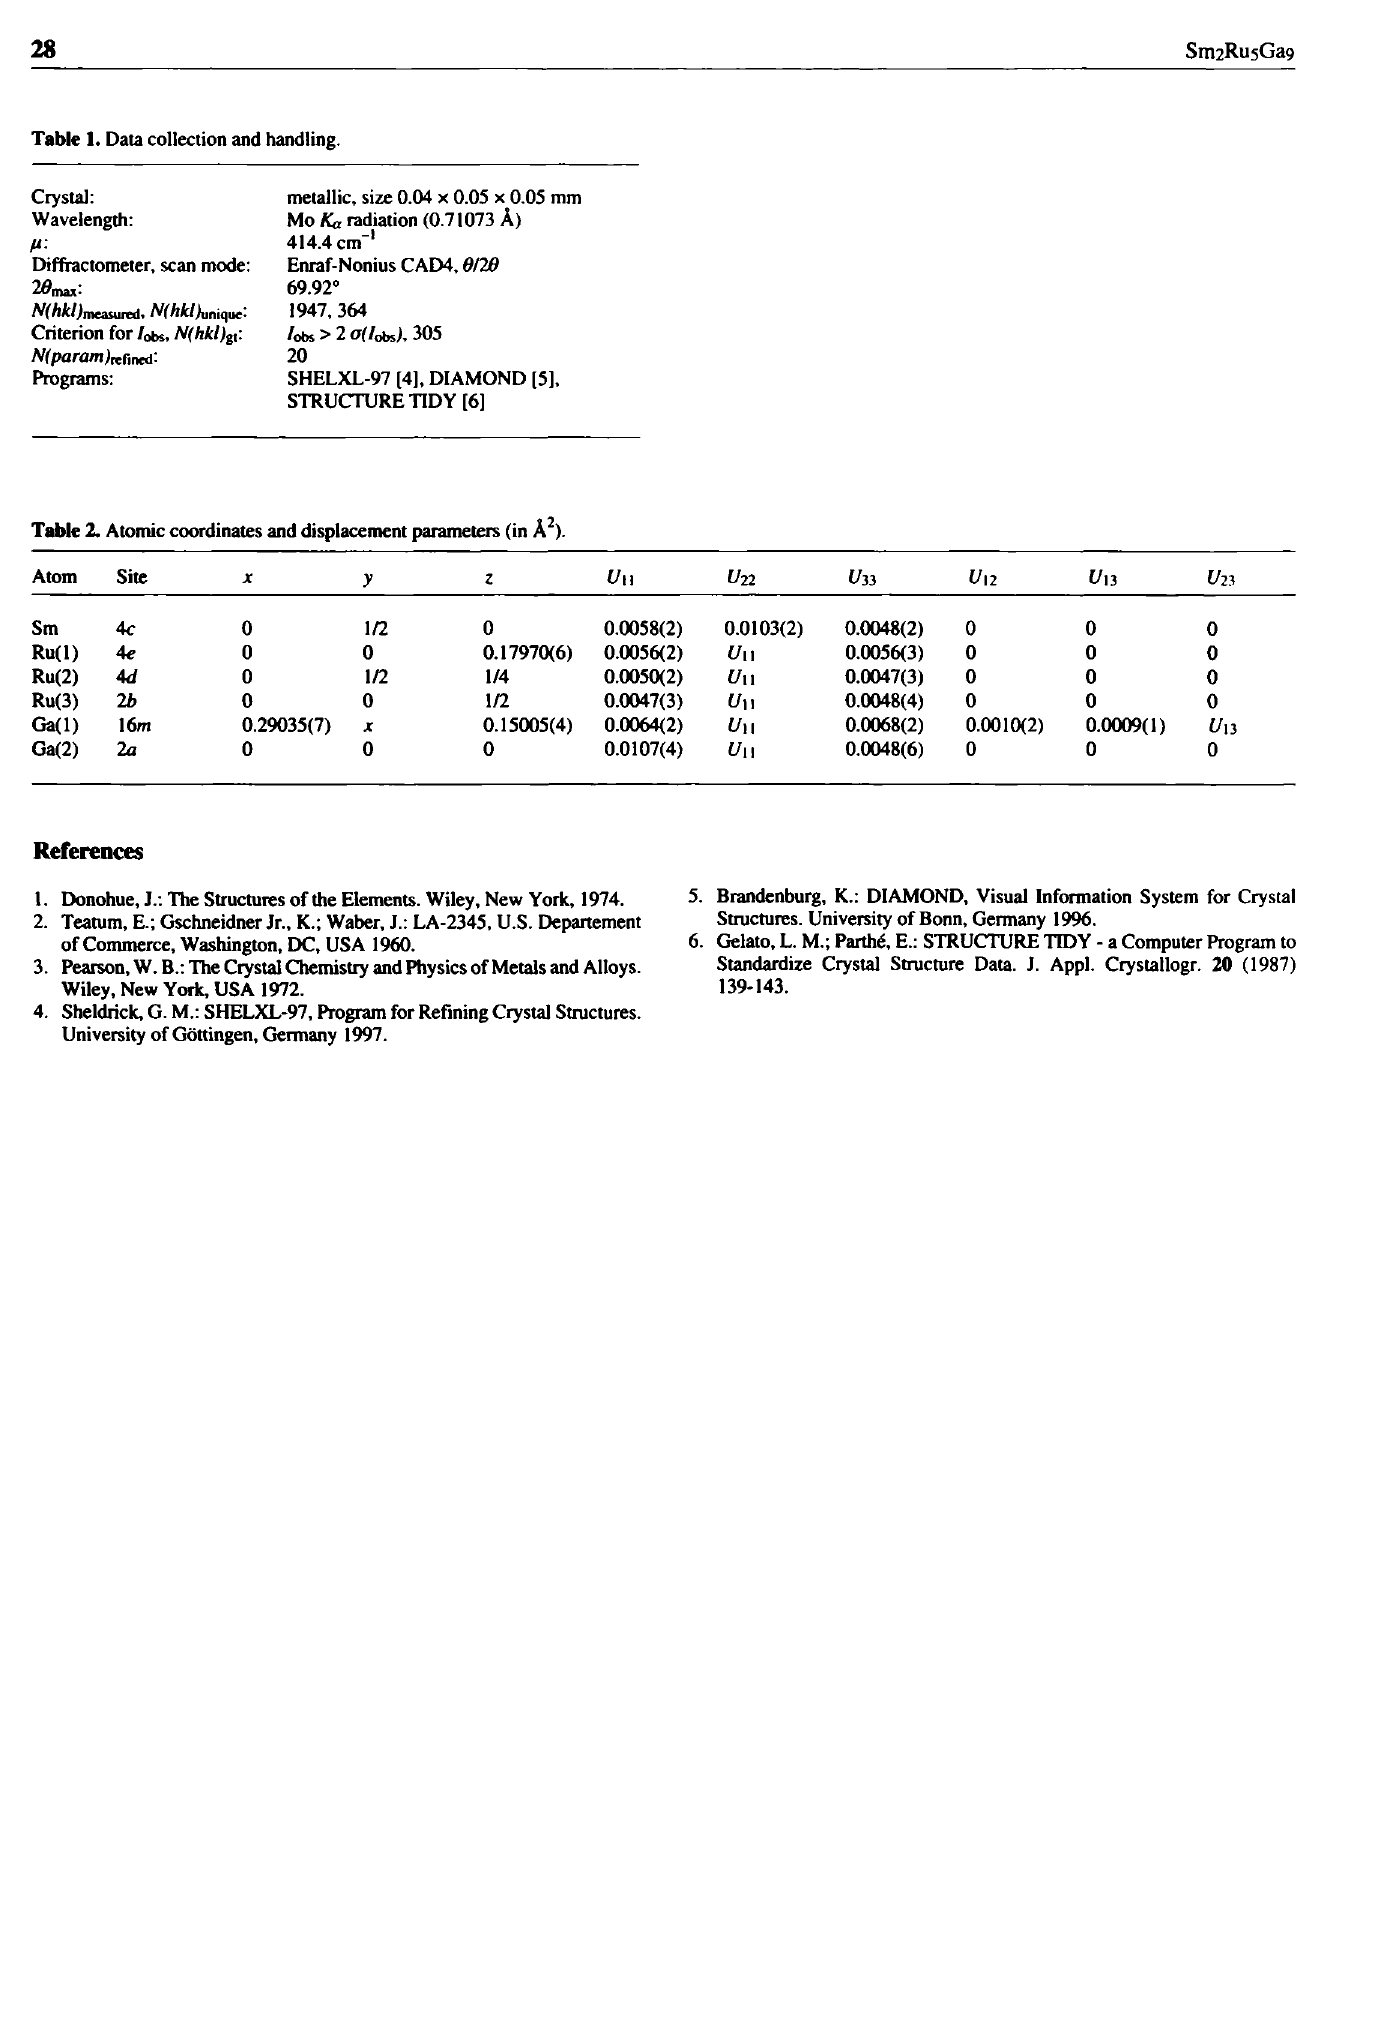
Table 1. Data collection and handling.